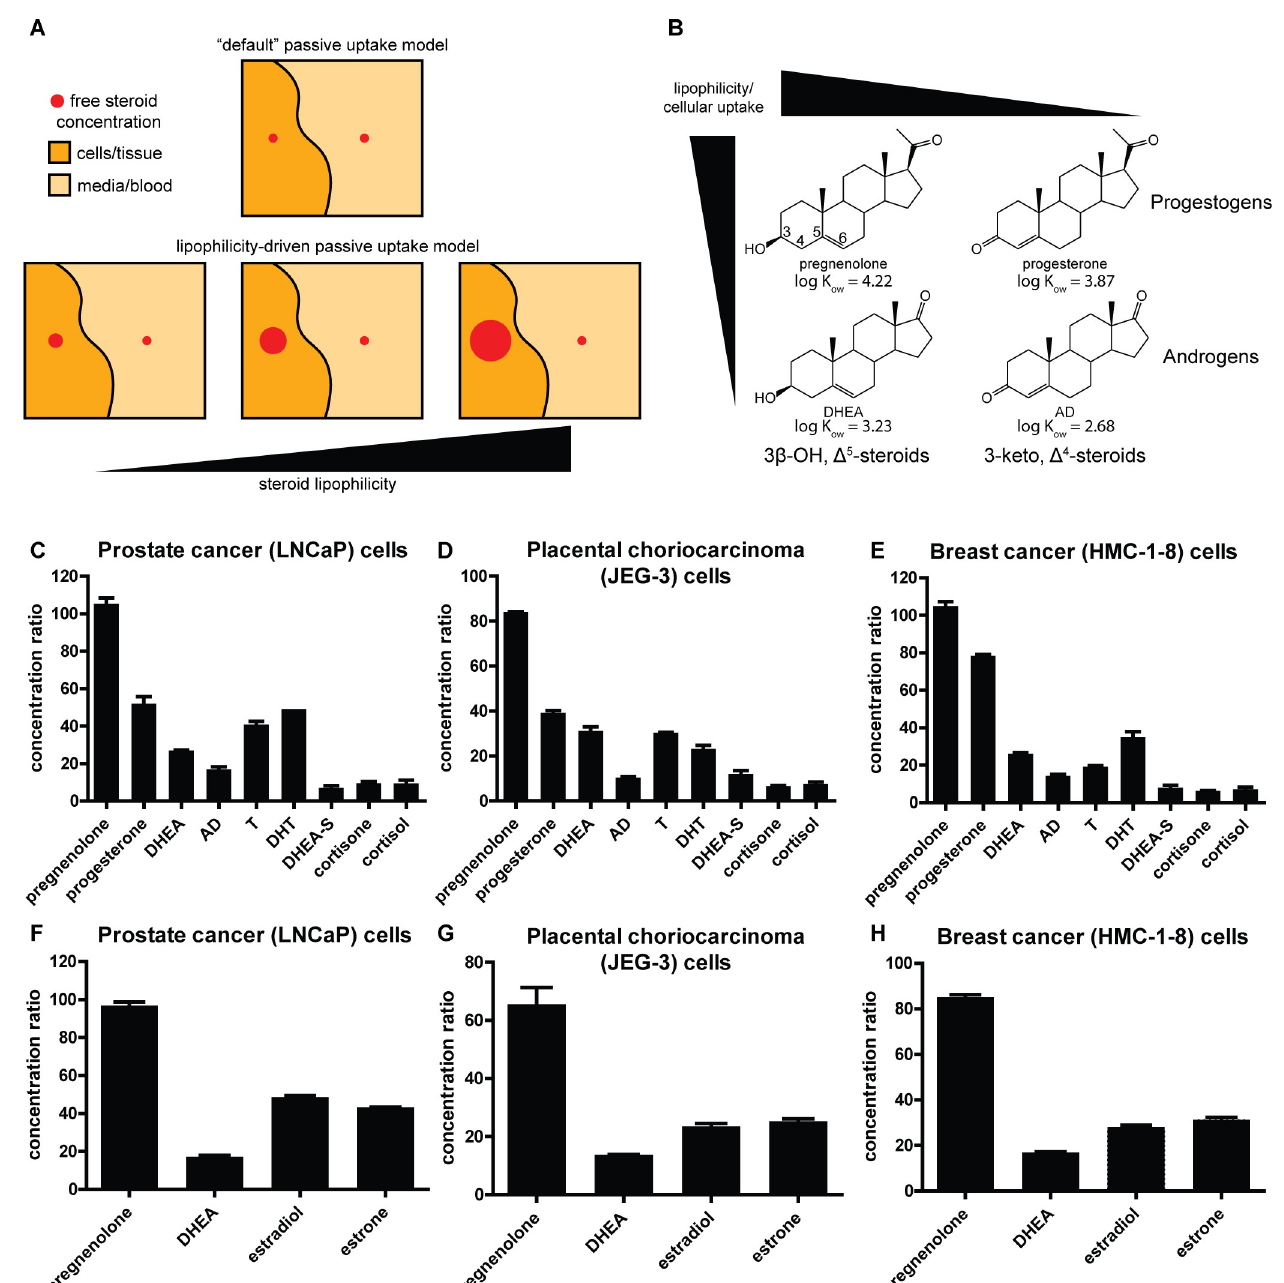
Fig 1. Cells derived from several tissue types accumulate steroids at high concentrations and uniformly have a preference for 3 β -OH, Δ 5 -steroids over 3-keto, Δ 4 -steroids and progestogens over androgens. (A) Schematic representation of cellular steroid uptake. In a model of uptake driven solely by passive diffusion and disregarding lipophilicity-driven bioaccumulation (top panel), concentrations of free steroids inside and outside cells would be equivalent. When lipophilicity-driven bioaccumulation is taken into account, steroid concentrations in cells or tissue can become greater than those in media or blood, and to a much greater extent for more lipophilic than for less lipophilic steroids. (B) A specific example of the concept schematically represented in (A) : degree of steroid uptake depends on molecular structure; for example, progestogens (e.g. pregnenolone and progesterone) are more lipophilic and are preferentially taken up more than corresponding androgens (e.g. DHEA and AD) and 3 β -OH, Δ 5 -steroids (e.g. pregnenolone and DHEA) are more lipophilic and are preferentially taken up more than corresponding 3-keto, Δ 4 -steroids (e.g. progesterone and AD). For reference, carbons 3, 4, 5, and 6 are labeled on the pregnenolone structure. Note the hydroxyl group at position 3 and double bond between carbons 5 and 6 on the 3 β -OH, Δ 5 -steroids and the carbonyl group at position 3 and double bond between carbons 4 and 5 on the 3-keto, Δ 4 -steroids. Log K ow values, a measure of lipophilicity [25], are shown for the four steroids. (C-E) Ratios of cellular concentrations to original treatment concentrations in culture media for nine different steroids in (C) prostate cancer (LNCaP) cells, (D) placental choriocarcinoma (JEG-3) cells, and (E) breast cancer (HMC-1-8) cells. (F-H) Ratios of cellular concentrations to original